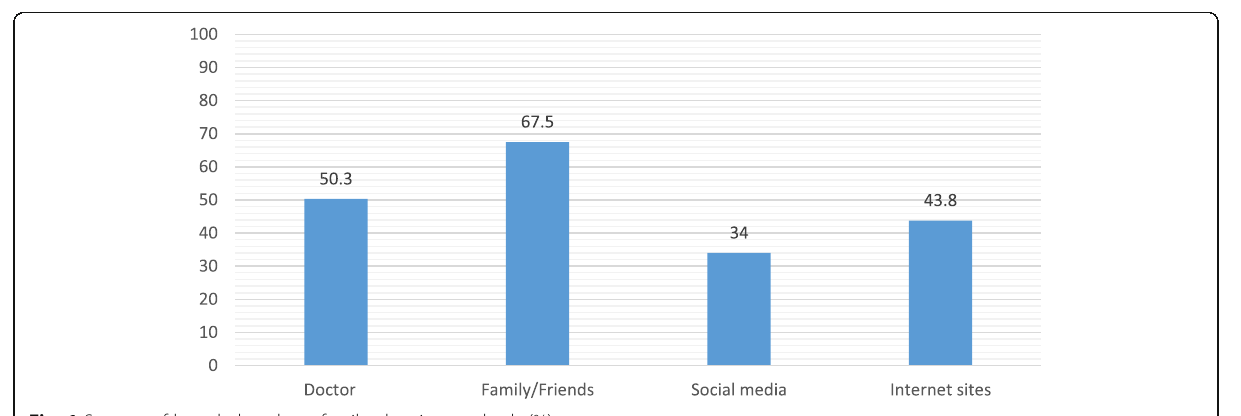
Fig. 1 Sources of knowledge about family planning methods